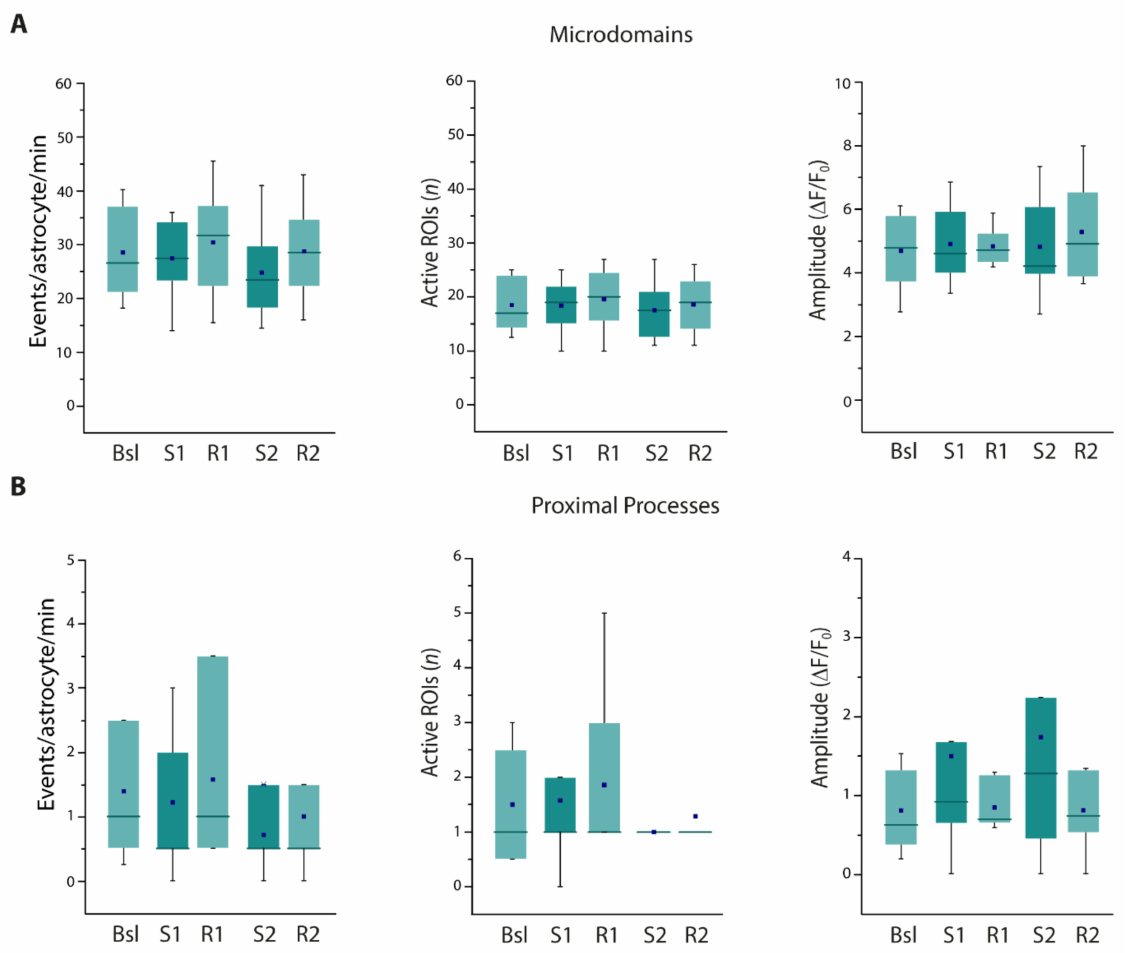
Figure 5. Astrocyte Ca 2+ response to STT interneuron stimulation is impaired in IP 3 R2KO mice. ( A , B ) Average data of astrocytic Ca 2+ signal dynamics at microdomains (2696 total events) ( A ) and proximal processes (102 total events) ( B ) before and after SST interneuron light pulse stimulation in IP 3 R2KO::SST-Cre mice (7–8 astrocytes, respectively; 6 slices, 3 mice).